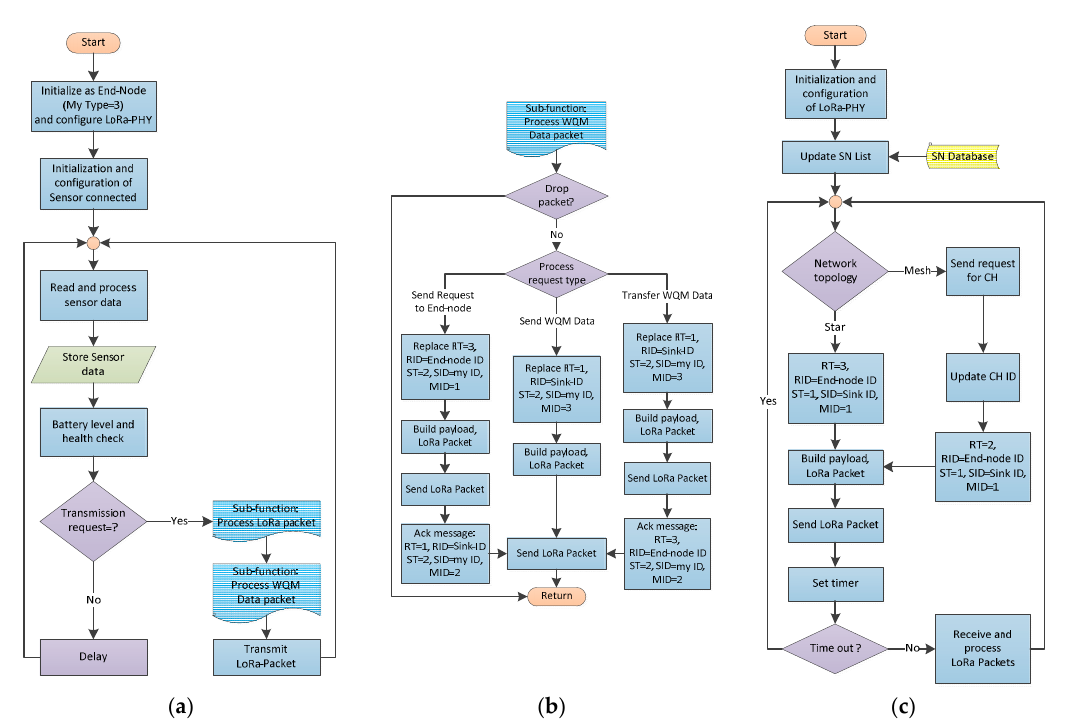
Figure 6. ( a ) Software algorithm for the SN, ( b ) SN dynamic routing algorithm, and ( c ) software algorithm for the DS.